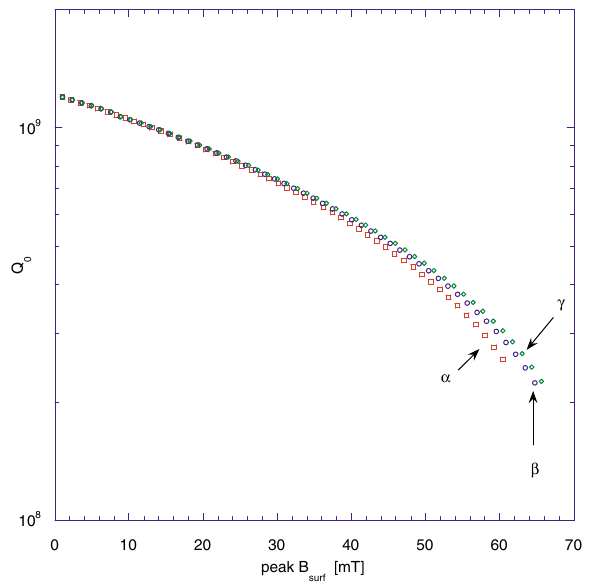
FIG. 9. (Color) Performances of a three-pipes cooled, 700 MHz single cell, with different Nb purity. Curve ( A ) is for a RRR (cid:3) 50 , ( B ) for a RRR (cid:3) 100 , ( C ) RRR (cid:3) 250 , and ( D ) RRR (cid:3) 500